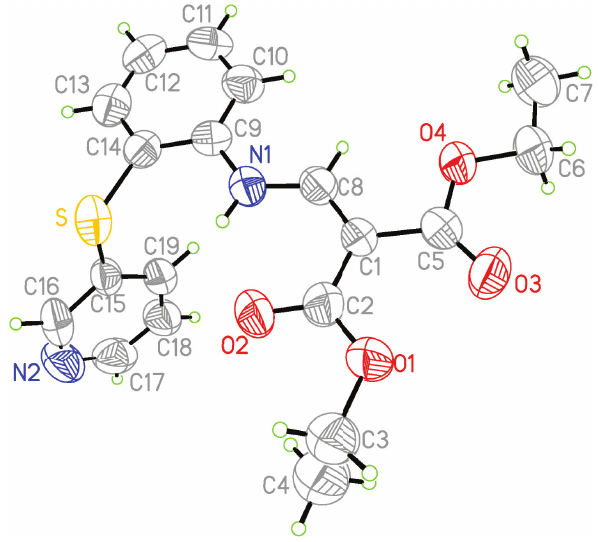
Table 1: Data collection and handling.